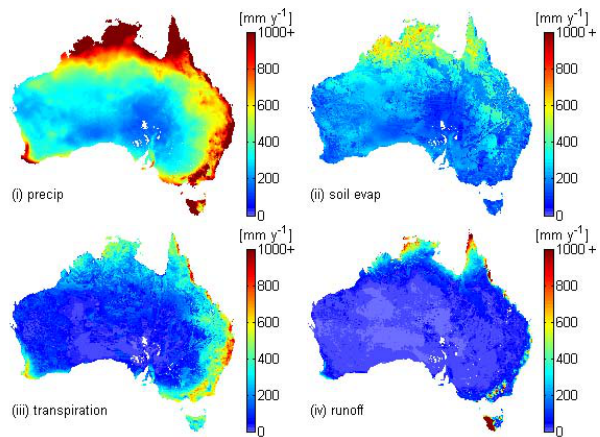
Fig. 12. Maps of terms in long-term (1990–2011) water balance: (i) precipitation; (ii) soil evaporation; (iii) transpiration; and (iv) runoff.